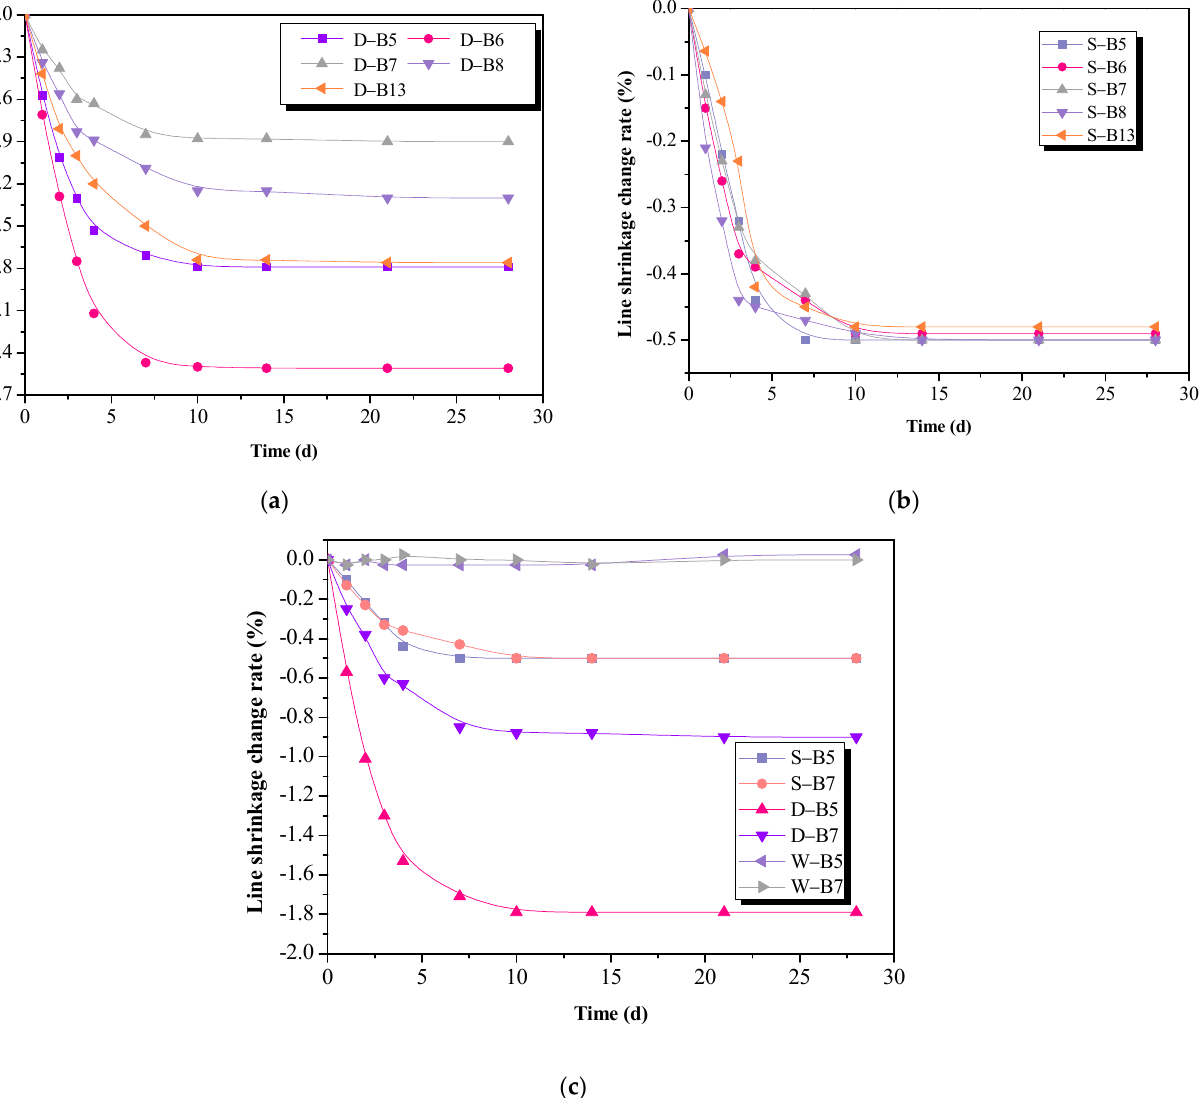
Figure 4. Effect of curing condition on the linear shrinkage of AA-FASM. ( a ) Dry curing. ( b ) Seal curing. ( c ) Linear shrinkage change rate of B5 and B7.